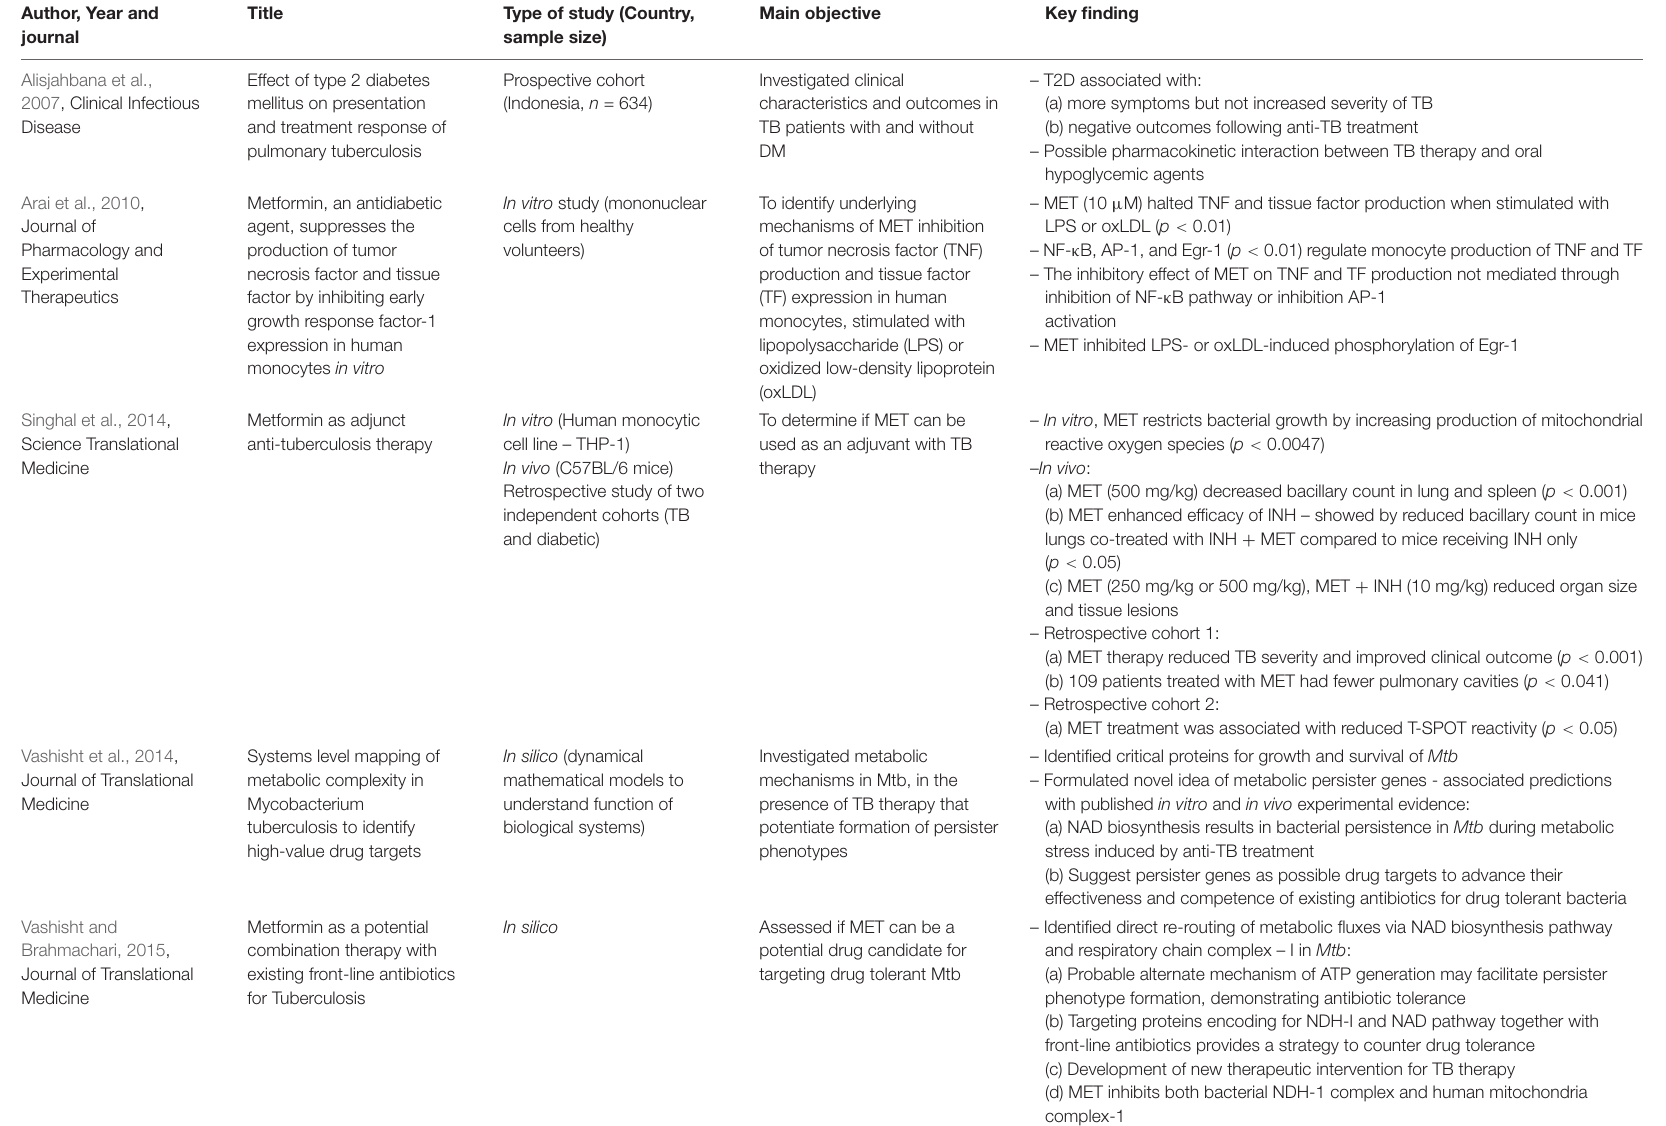
TABLE 2 | In vitro , in vivo , prospective, and retrospective studies evaluating the role of metformin in TB: